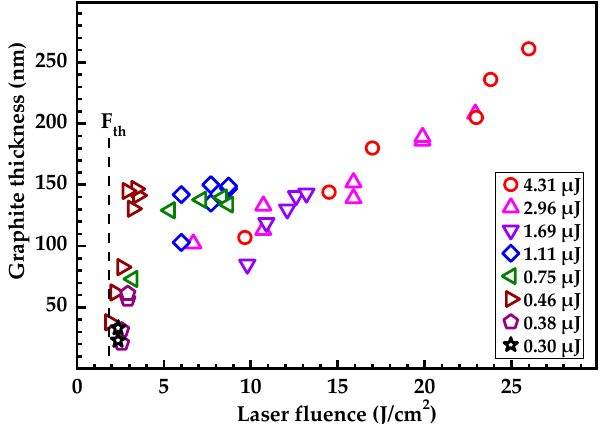
Figure 3. Thickness of graphitized layer deduced from intensity of Raman diamond line versus the laser fluence. F th denotes graphitization threshold. Legend denotes the energies at which the spots explored were produced.